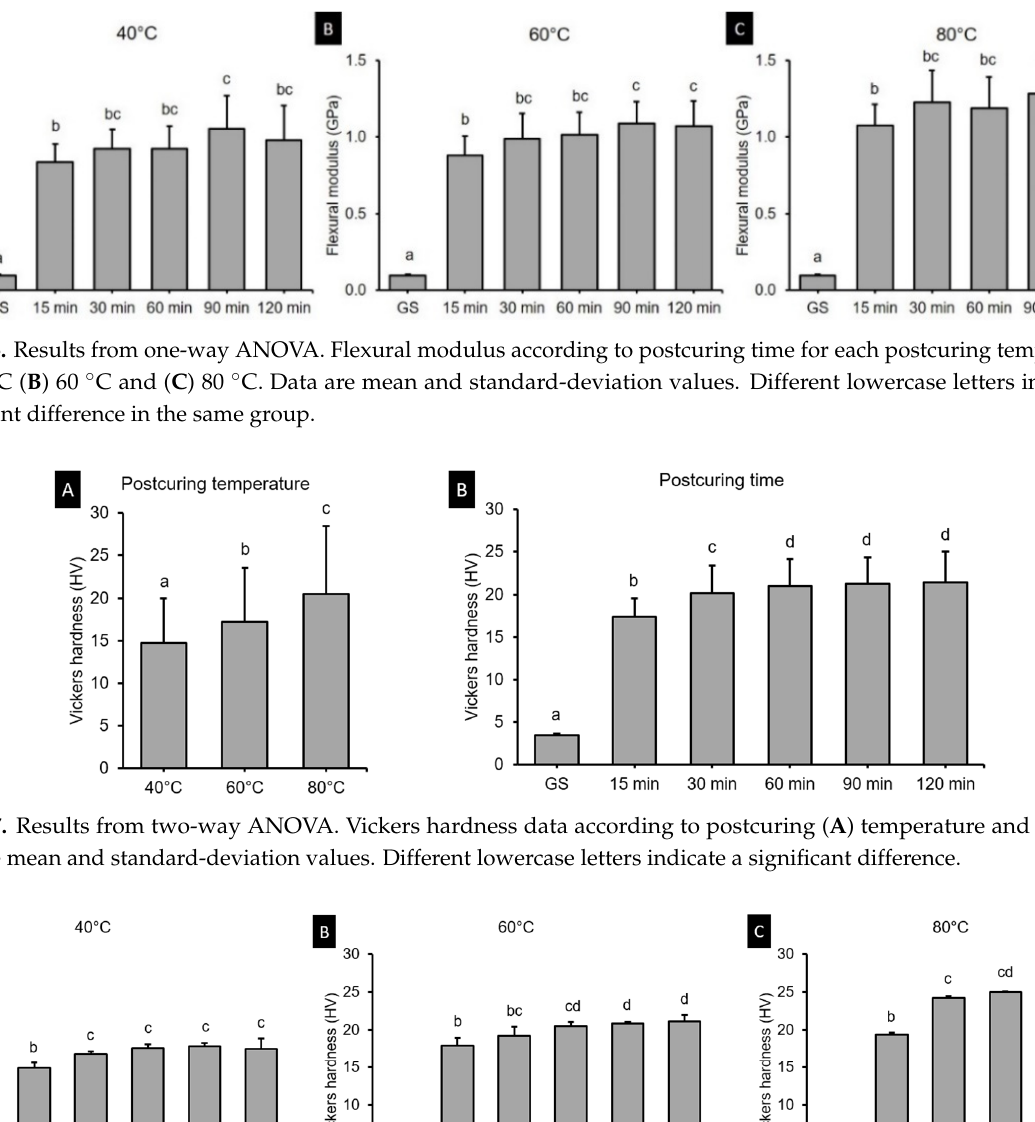
Figure 7. Results from two-way ANOVA. Vickers hardness data according to postcuring ( A ) tem- perature and ( B ) time. Data are mean and standard-deviation values. Different lowercase letters indicate a significant difference.